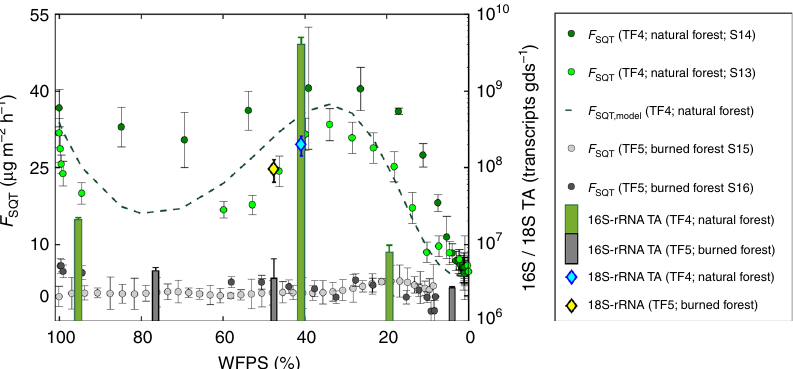
Fig. 4 SQT emissions and rRNA transcript abundance. SQT emissions (markers, dashed line as model output) and 16S-/18S- rRNA transcript abundance (TA) during desiccation of soil samples from organic (O) horizon from TF4 to TF5. Green circles (dark green for S14 and light green for S15) indicate the SQT fl uxes for TF4 while light (S15) and dark gray bullets (S16) indicate the fl uxes for TF5. The error bars indicate the standard deviations of four sample points at the respective moisture level. Green bars indicate the 16S rRNA transcript abundance (transcripts per grams of dry soil, gds − 1 ) for TF4 (S13) and black/gray bars the transcript abundance (gds − 1 ) for TF5 (S16). The cyan diamond indicates the 18S rRNA copies for TF4 (S13) and the yellow diamond the respective result for TF5 (S16). Under wet and dry conditions the 18S rRNA transcripts gds − 1 were below 1e7 transcripts gds − 1 and are not displayed. The error bars in the box-whisker plots indicate the standard deviation of four